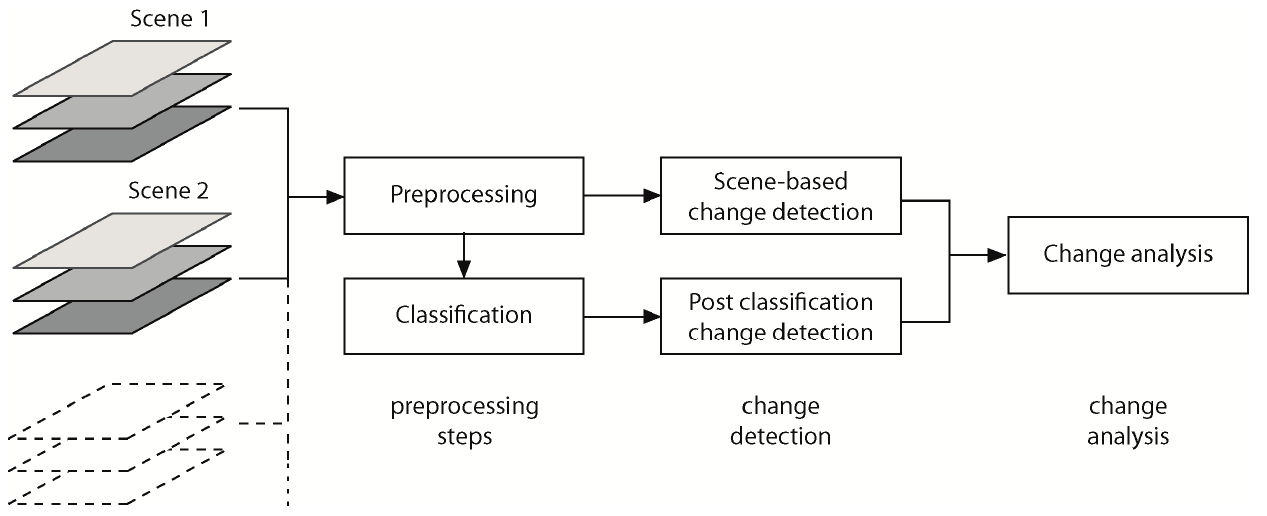
Figure 1. Common workflow including change detection and analysis as separate